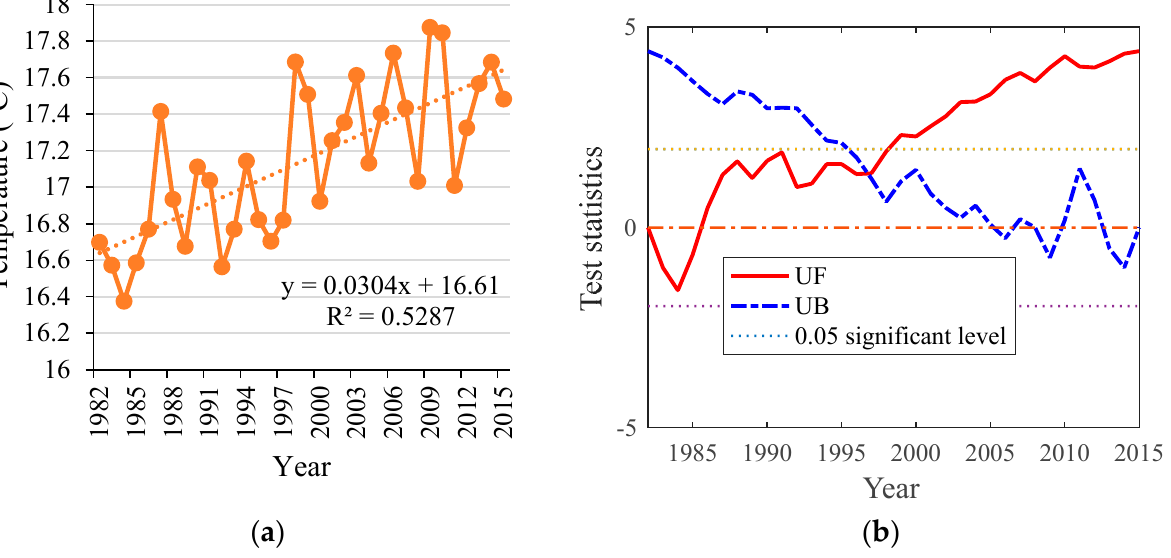
Figure 4. Temporal variation ( a ) and mutation detection ( b ) of the annual mean temperature in the karst areas of Southwest China from 1982 to 2015.